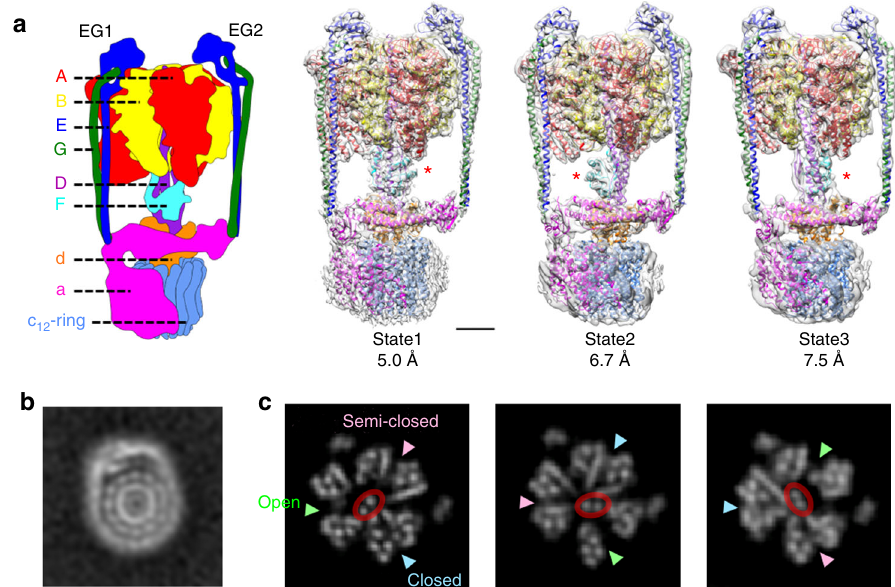
Fig. 1 Three different structures of the V/A-ATPase from T. thermophilus . a A schematic model of V/A-ATPase from T. thermophilus is shown in left and the color of each subunit is corresponding to the models shown in right. Atomic models of the three rotational states were fi tted into the maps by MDFF (right). The experimental maps are shown in semi-transparent gray. The central rotor subunit F is indicated by a red asterisk for each state. Scale bar, = 30Å. b A cross-section through the hydrophobic region in state1, showing that α -helices of outer ring of c-subunits are well resolved. c Cross-sections through the hydrophilic region of each map. The coiled-coil of the D-subunit is circled in red. The three AB interfaces are indicated by arrows in the section of